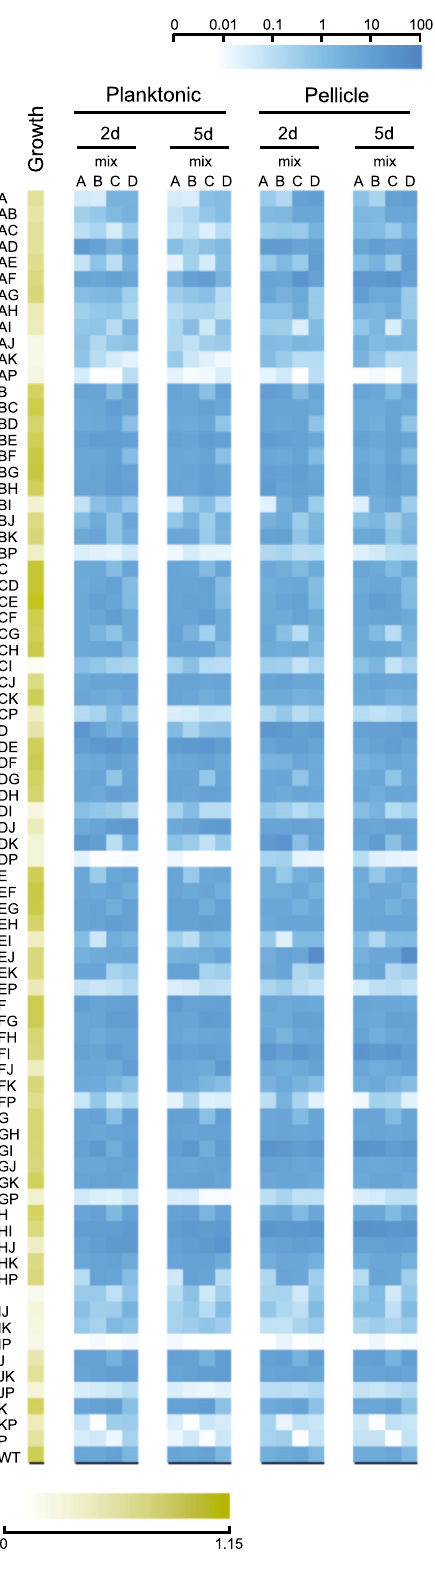
Fig. 5 Heat map comparing growth of B. subtilis rap – phr mutants (16 h) to their population percentage after the fi rst culture cycle (t1). Yellow boxes represent 16-h growth on MSgg medium as increase in O.D. 590 . The yellow intensity scale bar (bottom) indicates O.D. 590 increment. Blue boxes represent the population percentage of all tested strains. The blue intensity scale bar (top) indicates increment of percentage. Each blue box represents the average percentage of six population replicates per starter mix. Text rows on top indicate type of culture (planktonic or pellicle), incubation period (2d = 2 days, 5d = 5 days), and starter mix (A, B, C or D). Text columns at far-left indicate which rap – phr genes have been deleted (A indicates a Δ rapA mutant, ab indicates a Δ rapAB mutant, and so on), WT indicates B.